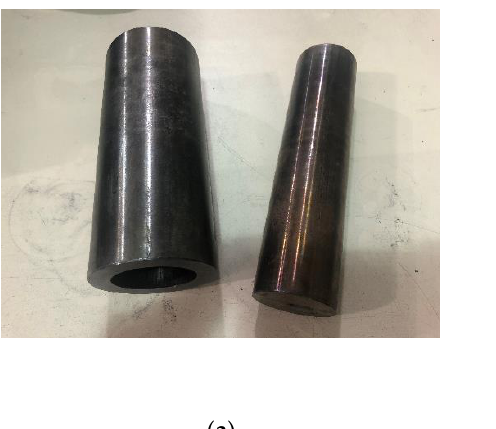
ranging from 200 °C to 1000 °C). Table 3 categorizes the samples that aimed for different characteriza- tions. Figure 1. Device for the compaction of the anode paste. ( a ) Rigid die; ( b ) MTS Servohydraulic press. The heating program, as shown in Figure 2, was used for the TGA analysis, the dila- tometry, the air permeability, and the helium-pycnometric measurements. The red dashed line corresponds to the heating program of the TGA analysis, where the samples were baked up to 1000 °C. Blue circles correspond to given target temperatures * T . Samples